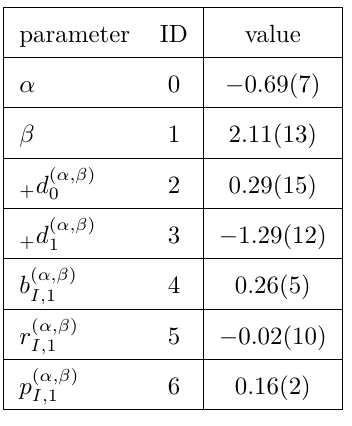
Table 6 . The values of the parameters from fitting the imaginary component to the model “default”. The ID numbers correspond to the labels in figure